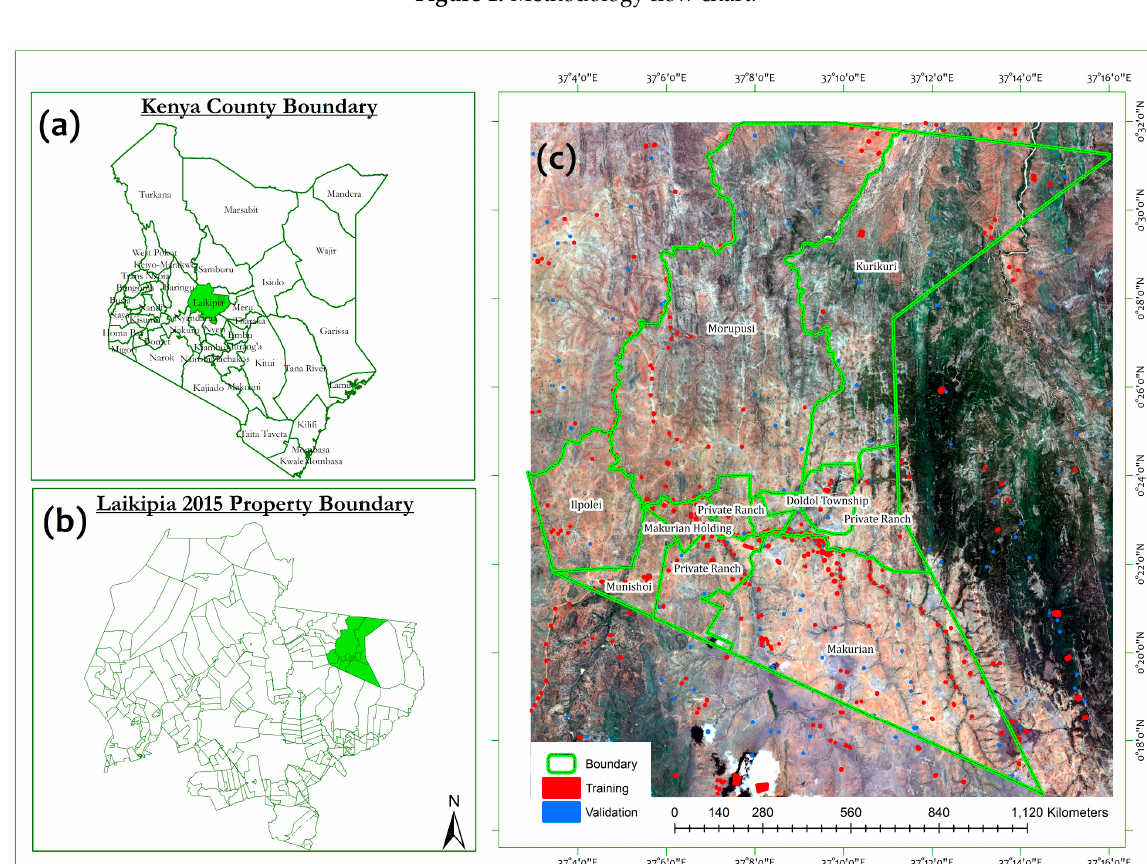
Figure 1. Methodology flow chart.